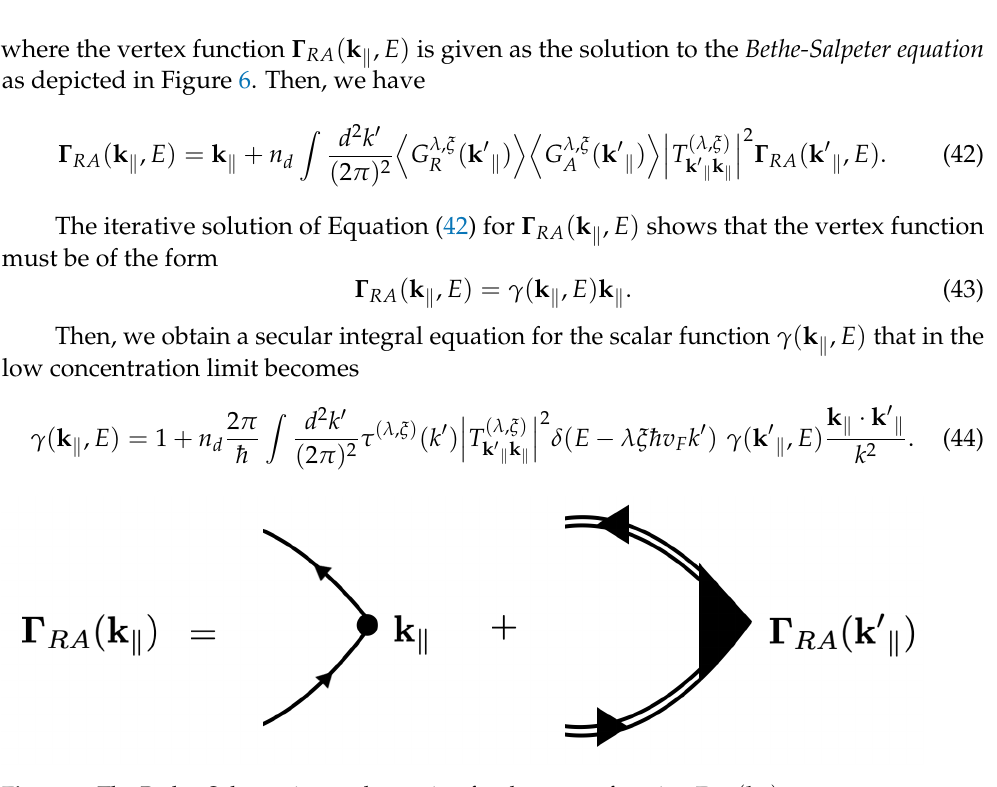
Figure 6. The Bethe–Salpeter integral equation for the vertex function Γ RA ( k (cid:107) )